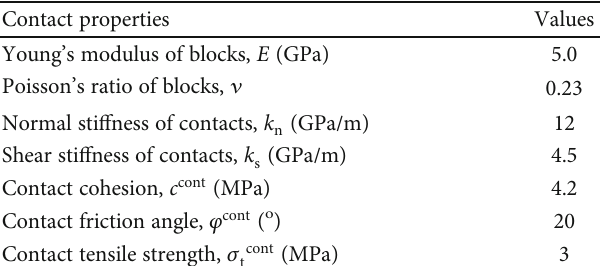
Figure 5: 3DEC numerical analysis model. (a) Complete model. (b) Grid re fi nement region. (c) Roadway roof. Table 1: Properties assumed in 3DEC model for immediate roadway